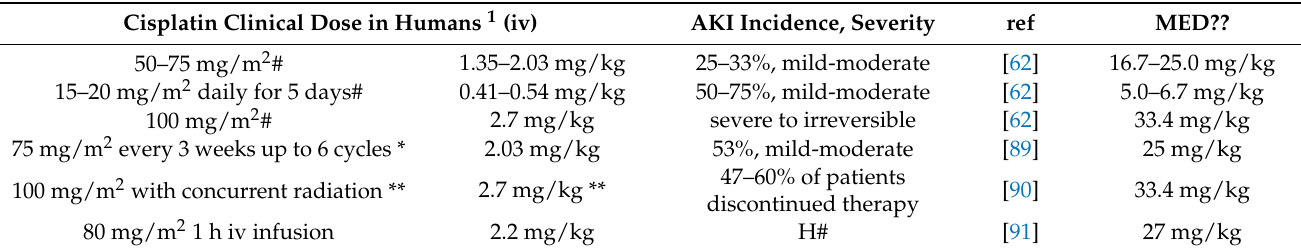
Table 2. Examples of cisplatin regimes used in the clinics and incidence of AKI complications. Cisplatin Clinical Dose in Humans 1